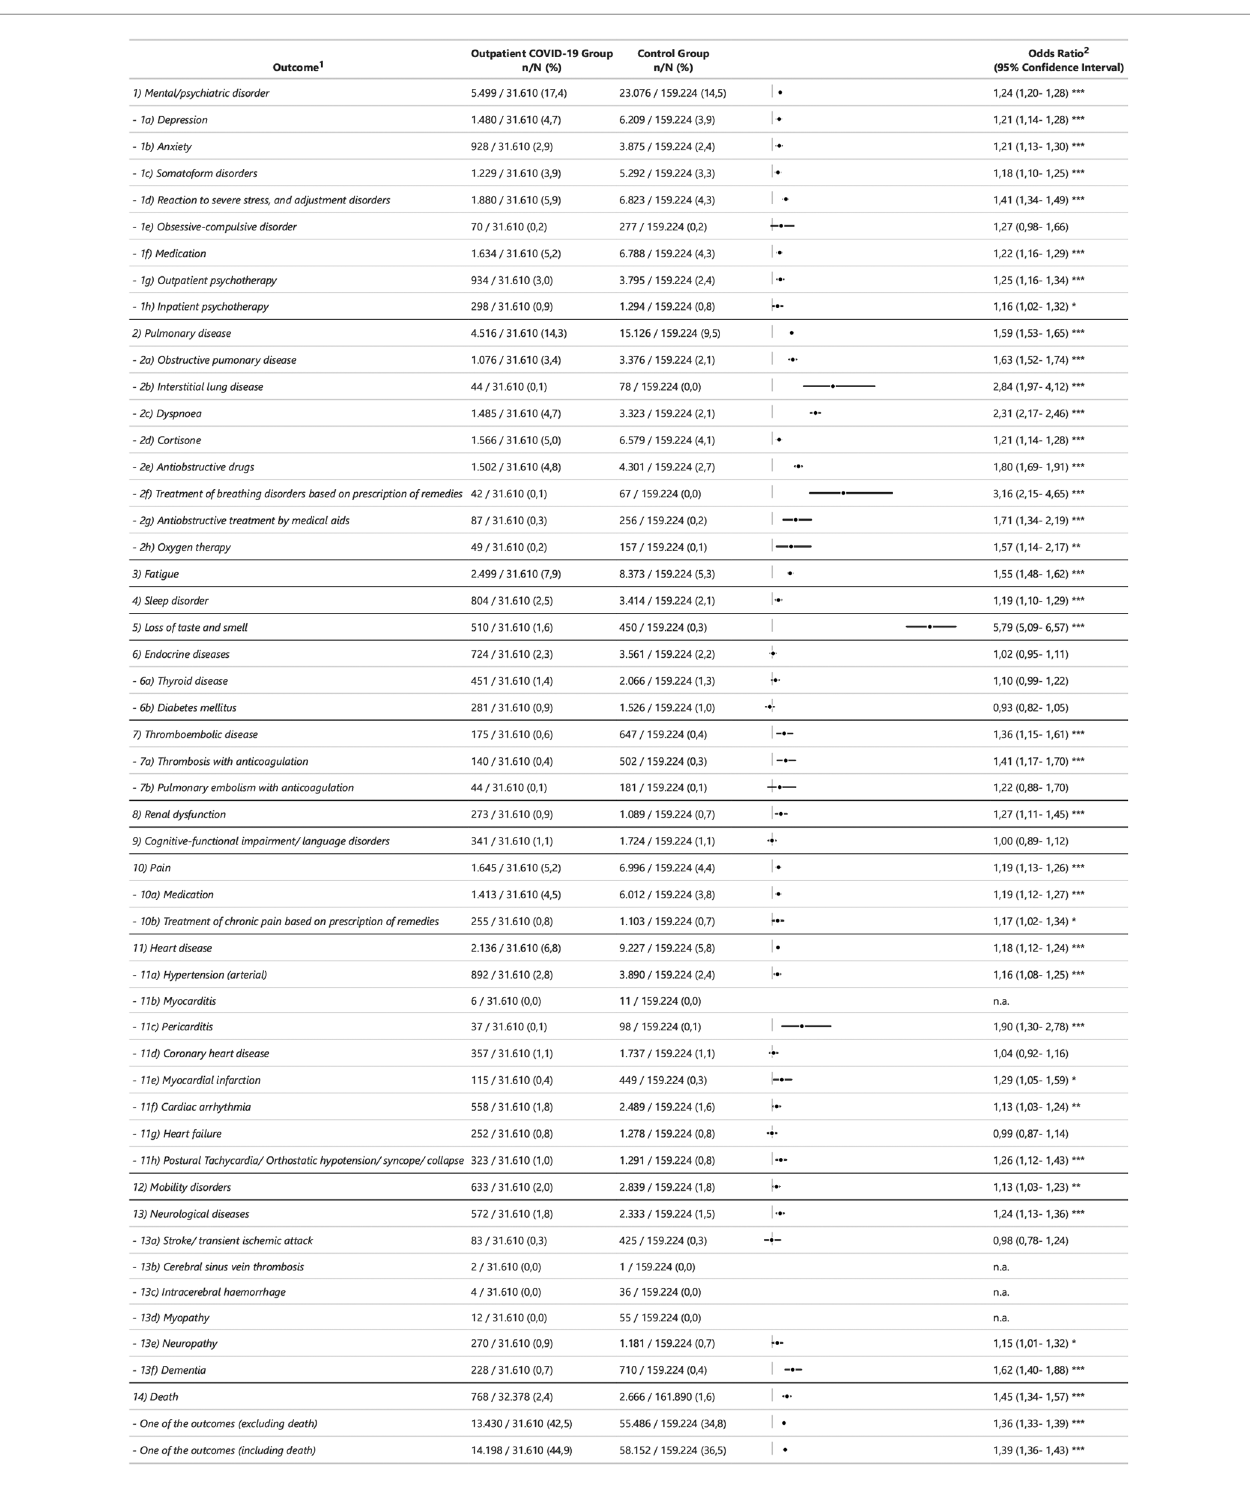
FIGURE 2 Descriptive results and odds ratios of outcome variables in the outpatient sample. 1 Operationalisation of the outcome variables is described in the supplement 1. 2 OR=Odds Ratio; CI=Con fi dence Interval; * p <=0.05; ** p <=0.01; *** p <=0.001; n.a.=not assessed when value <10 (also within the sex